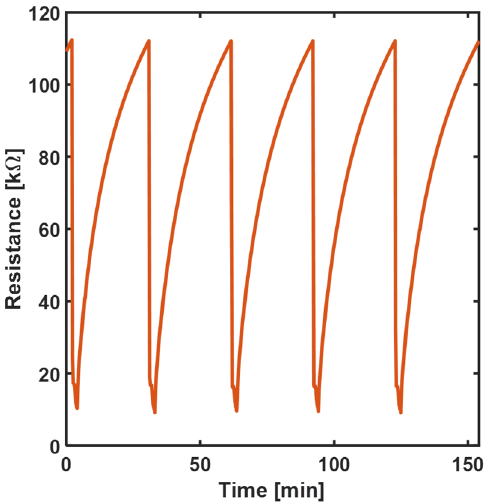
Figure 4. Repetitive cycles of resistance variation towards 30 ppm NO 2 .